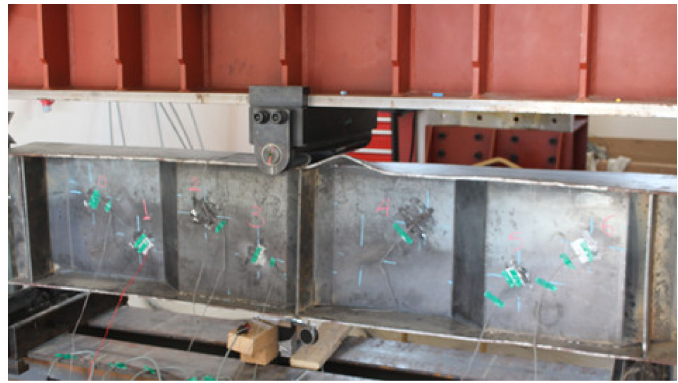
Figure 9. Failure mode of specimen CW35IFWL.